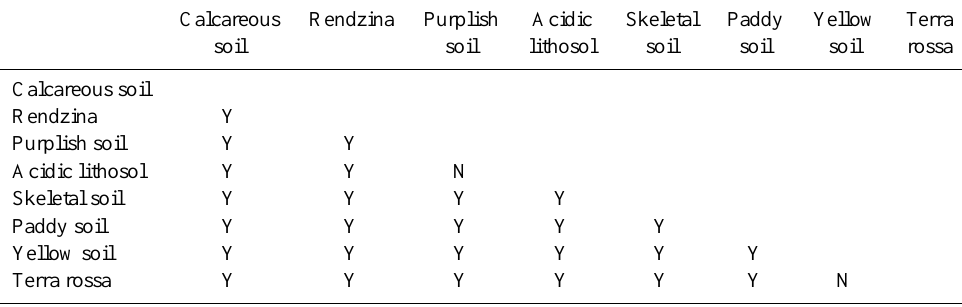
Table 6. Difference of mean deterioration KRD index between soil types. Calcareous Rendzina Purplish Acidic Skeletal Yellow soil soil lithosol soil soil soil rossa Calcareous soil